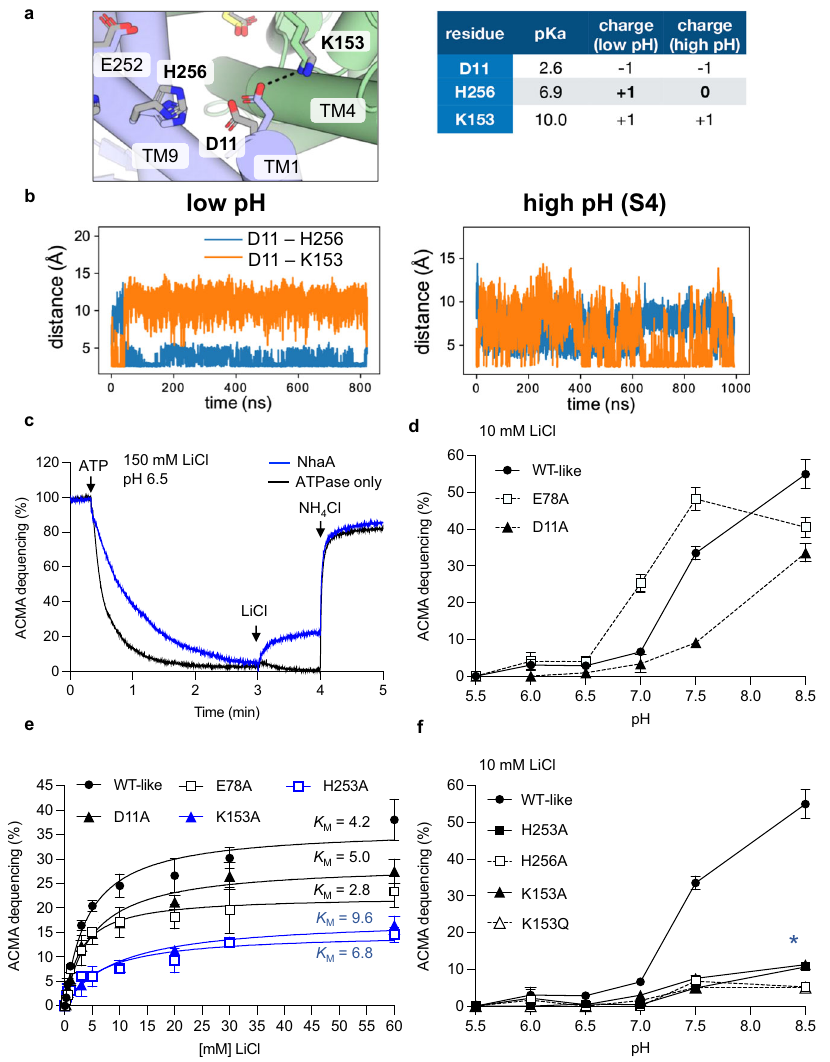
Fig. 3 | Salt-bridge interactions in pH gate critical for pH activation. a left: Salt bridge switch between D11 and H256 and between D11 and K153. right: Predicted p K a and charge state atlowpH (3.5) and high pH (7.5). b . Representative MD times seriesofsaltbridgedistancesforlowpH(left)andhighpH(right, “ S4 ” protonation statewithnoprotonsboundinthebindingsite)showingsaltbridgeswitching.The protonationstateofH256differsbetweenlowandhighpHasindicatedin( a ). c The ATP(adenosinetriphosphate)synthaseandthe Ec NhaAWT-liketriplemutantwere co-reconstitutedinliposomes.ATP-drivenprotonpumpingestablishesapH(acidic inside) as monitored by the quenching of 9-amino-6-chloro − 2- fl uorescence (ACMA).Protonef fl uxisinitiatedbytheadditionof150mMLiClatpH6.5forNhaA triple mutant (blue trace) and empty liposomes (black trace). d pH dependence of NhaA Li + – H + antiporter activity for WT-like triple mutant (closed circle), Glu78Ala (open squares) and Asp11Ala (closed triangles) weremeasured in proteoliposomes